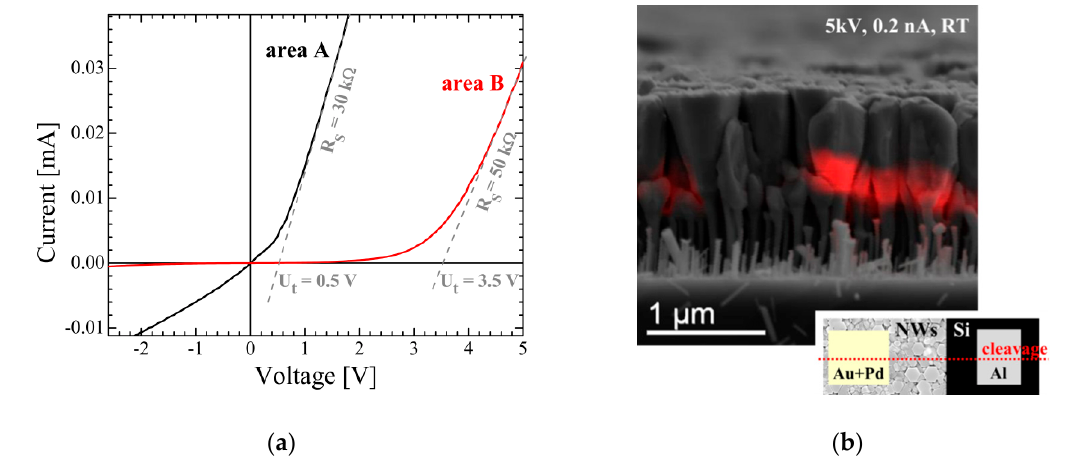
Figure 9. ( a ) Macroscopic I–V curves of the A and B areas of the wafer. Lines fitted to the curves show serial resistance deduced from the slope and turn-on voltage deduced from the crossing with the zero axis. ( b ) SEM image (grey) with the superimposed EBIC signal (red) of the LED NWs. The strong EBIC signal reveals the position of the active p–n junction. The inset shows the geometry of the contacts.